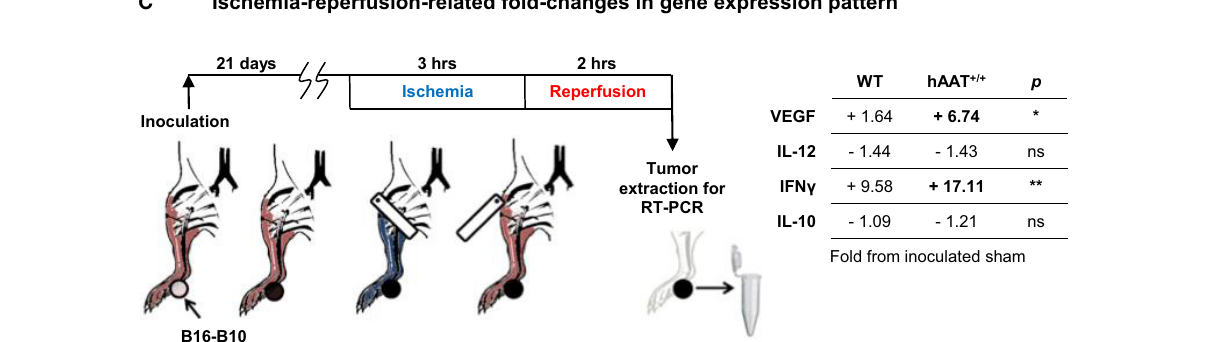
FigUre 7 | evidence for context-specific activities of haaT . (a,B) S-NO-AAT induces pro-inflammatory effects on BMDM stimulation and tumor cell viability. (a) BMDMs (1 × 10 6 cells per well in triplicate) were pretreated with hAAT (2.5 mg/ml), S-NO-hAAT (2.5 mg/ml), or GSNO (27.5 μ M) and after 24 h were cocultured with RMA cells (2.5 × 10 5 cells per well) with or without stimulation with IFN γ and IL-1 β (both at 10 ng/ml). RMA cells were diluted 1:4 after 48 h, and after 72 h (i) cells were washed and stained for flow cytometric analysis, and (ii) supernatants were analyzed for NO levels. Mean ± SEM, * p < 0.05. Unpaired two-tailed Student’s t -test was employed to assess differences between groups. (B) RMA cells were seeded at 1 × 10 5 cells per well and treated with hAAT, S-NO-hAAT (both at 2.5 mg/ml), GSNO (27.5 μ M), or doxorubicin (60 μ M). (i) Cells were stained with trypan blue, and the population of viable cells was determined after 24 h. (ii) LDH release after 48 h. (iii) 7-AAD staining. Mean ± SEM, * p < 0.05, *** p < 0.001. Unpaired two-tailed Student’s t -test was employed to assess differences between groups. (c) Effect of ischemia–reperfusion on intra-tumor gene expression profile during hAAT treatment. C57BL/6 mice ( n = 3 per group) were pretreated with hAAT (2 mg per animal, i.p.) 24 h prior to inoculation of B16-F10 melanoma cells (5 × 10 4 cells per mouse, i.f.p . ). Mice were subjected to limb ischemia–reperfusion (3 h ischemia; 2 h reperfusion) on day 21 post-inoculation. Mice were then sacrificed, and total foot tissue surrounding the inoculation site was excised and processed for real-time QPCR gene expression analysis for indicated genes. Results are presented as fold-change from inoculated sham-operated mice. * p < 0.05, ** p < 0.01 between hAAT + / + and WT groups. Unpaired two-tailed Student’s t -test was employed to assess differences between